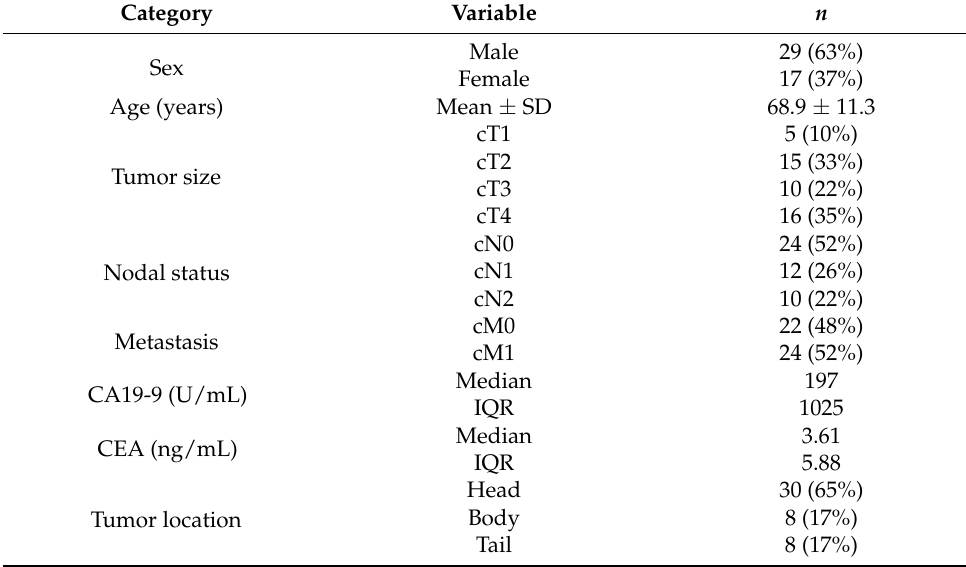
Table 1. Displaying patient characteristics.